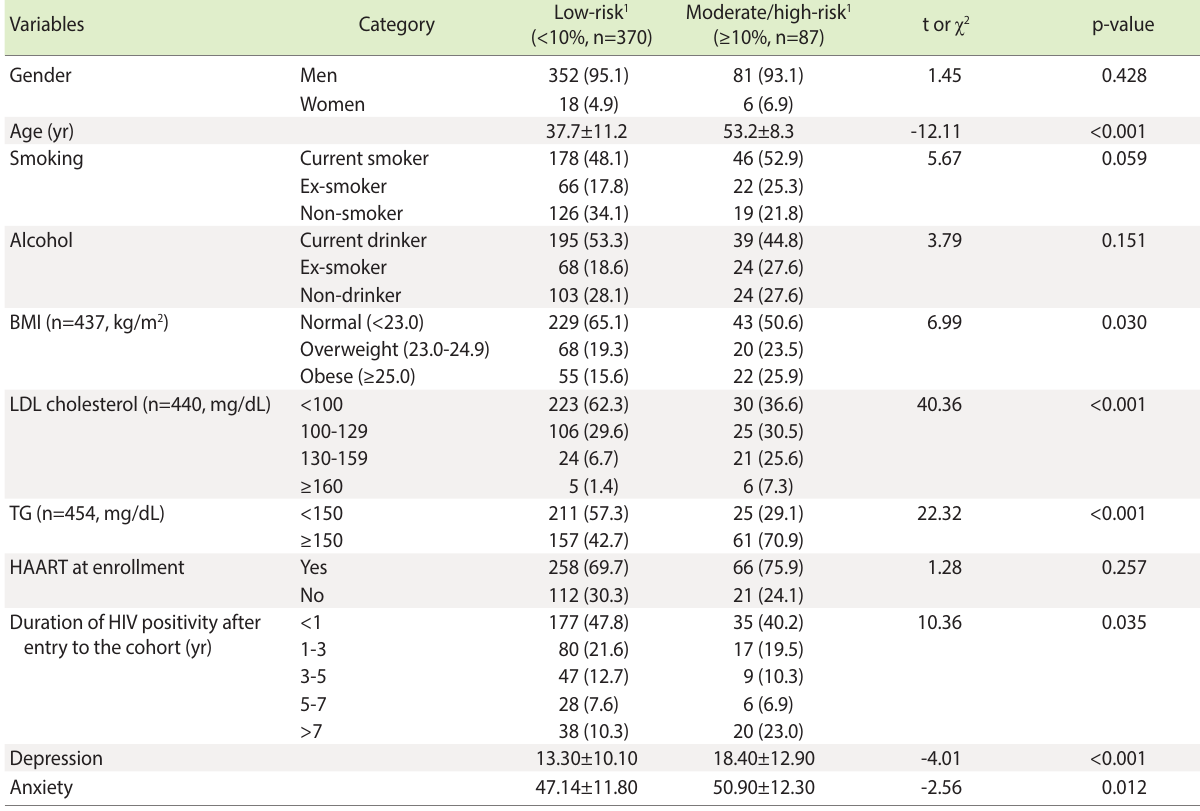
BMI, body mass index; LDL, low density lipoprotein; TG, triglycerides; HAART, highly active antiretroviral therapy; HIV, human immu nodeficiency virus. 1 Corresponding to the 10-year risk of cardiovascular